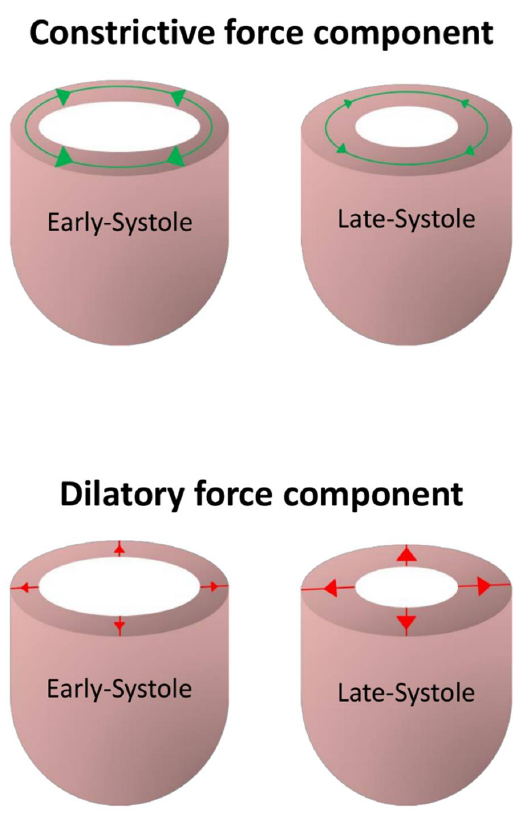
Figure 6. The drawings show the essence of mural antagonism. During contraction, tangentially arranged chains of cardiomyocytes are subjected to a progressive decrease in hemodynamic afterload. Because of this, their force magnitude decreases over the cardiac cycle, thus producing a constrictive force component which is unloading in nature. In contrast, during cardiac contraction, those chains of cardiomyocytes aligned in transmural fashion are subjected to a progressive increase in intrinsic afterload. Their force magnitude, therefore, increases over the cardiac cycle, thus producing an antagonistic and dilatory force component, which is auxotonic in nature. Modified from Lunkenheimer et al., 2018 [16].